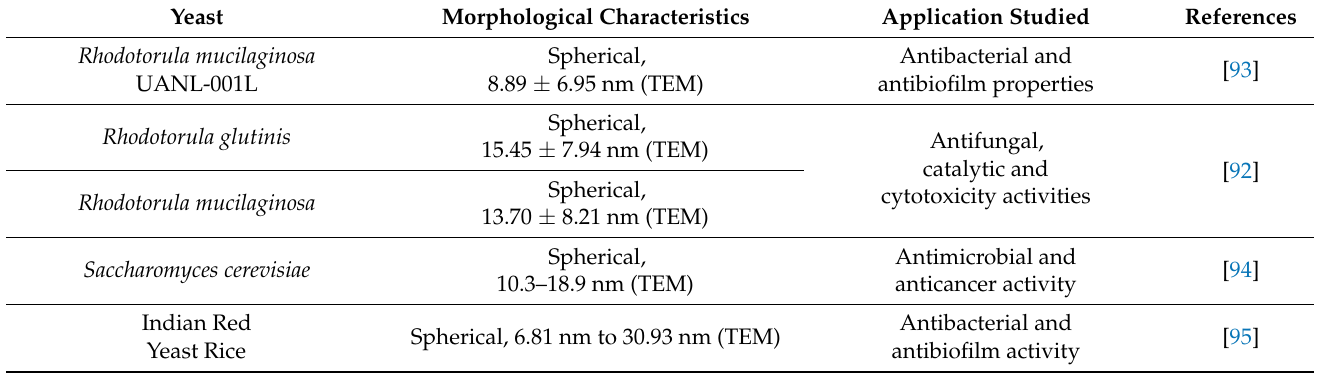
Table 4. Yeast-mediated synthesis of AgNPs, their morphological characteristics, and their